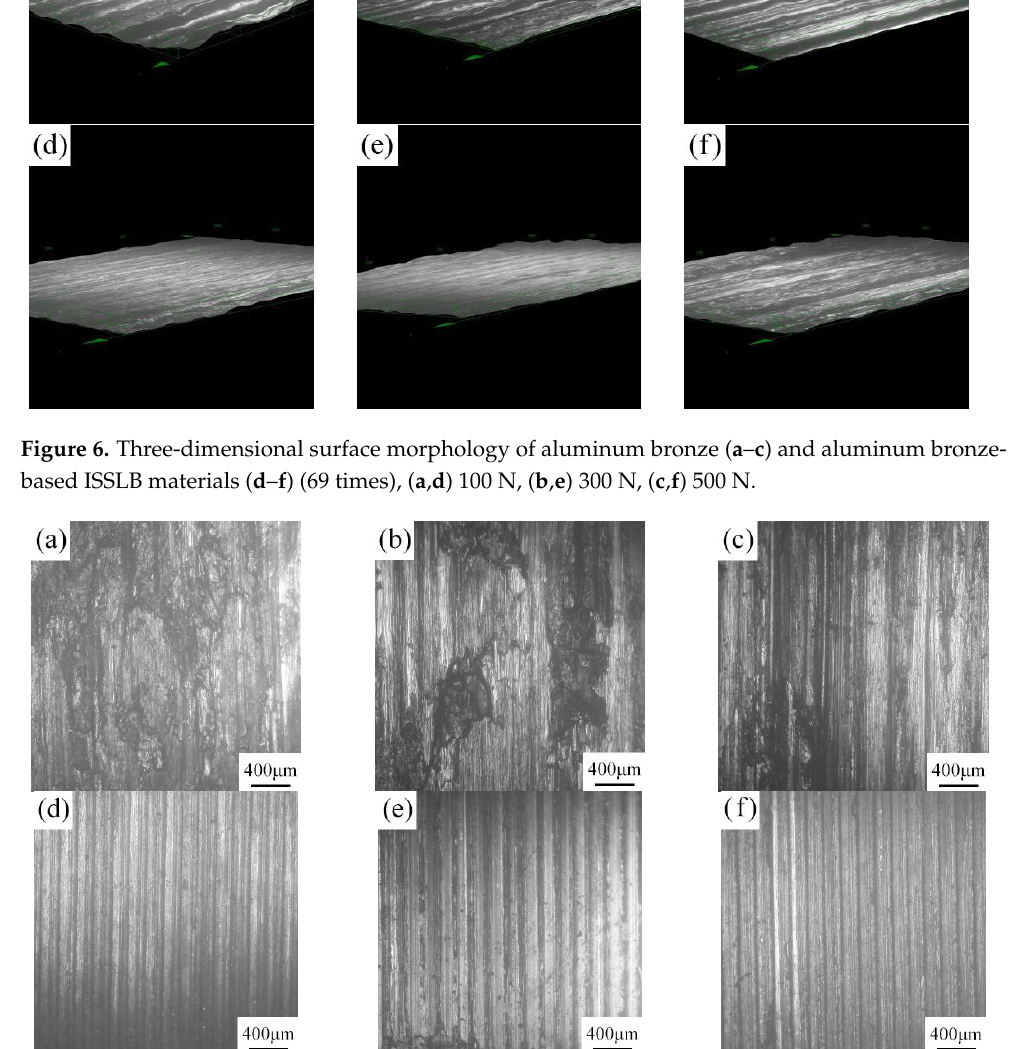
Figure 6. Three-dimensional surface morphology of aluminum bronze ( a – c ) and aluminum bronze-based ISSLB materials ( d – f ) (69 times), ( a , d ) 100 N, ( b , e ) 300 N, ( c , f ) 500 N.